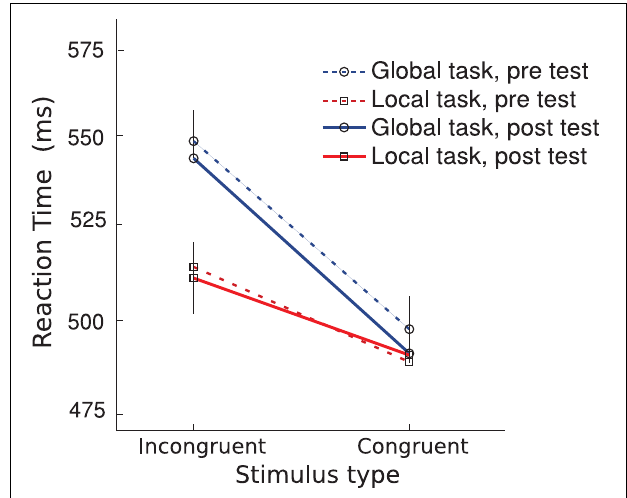
FIGURE 5 | Mean reaction time to respond to global and local features at pre and post test depending on the congruency of the stimuli in the global-local